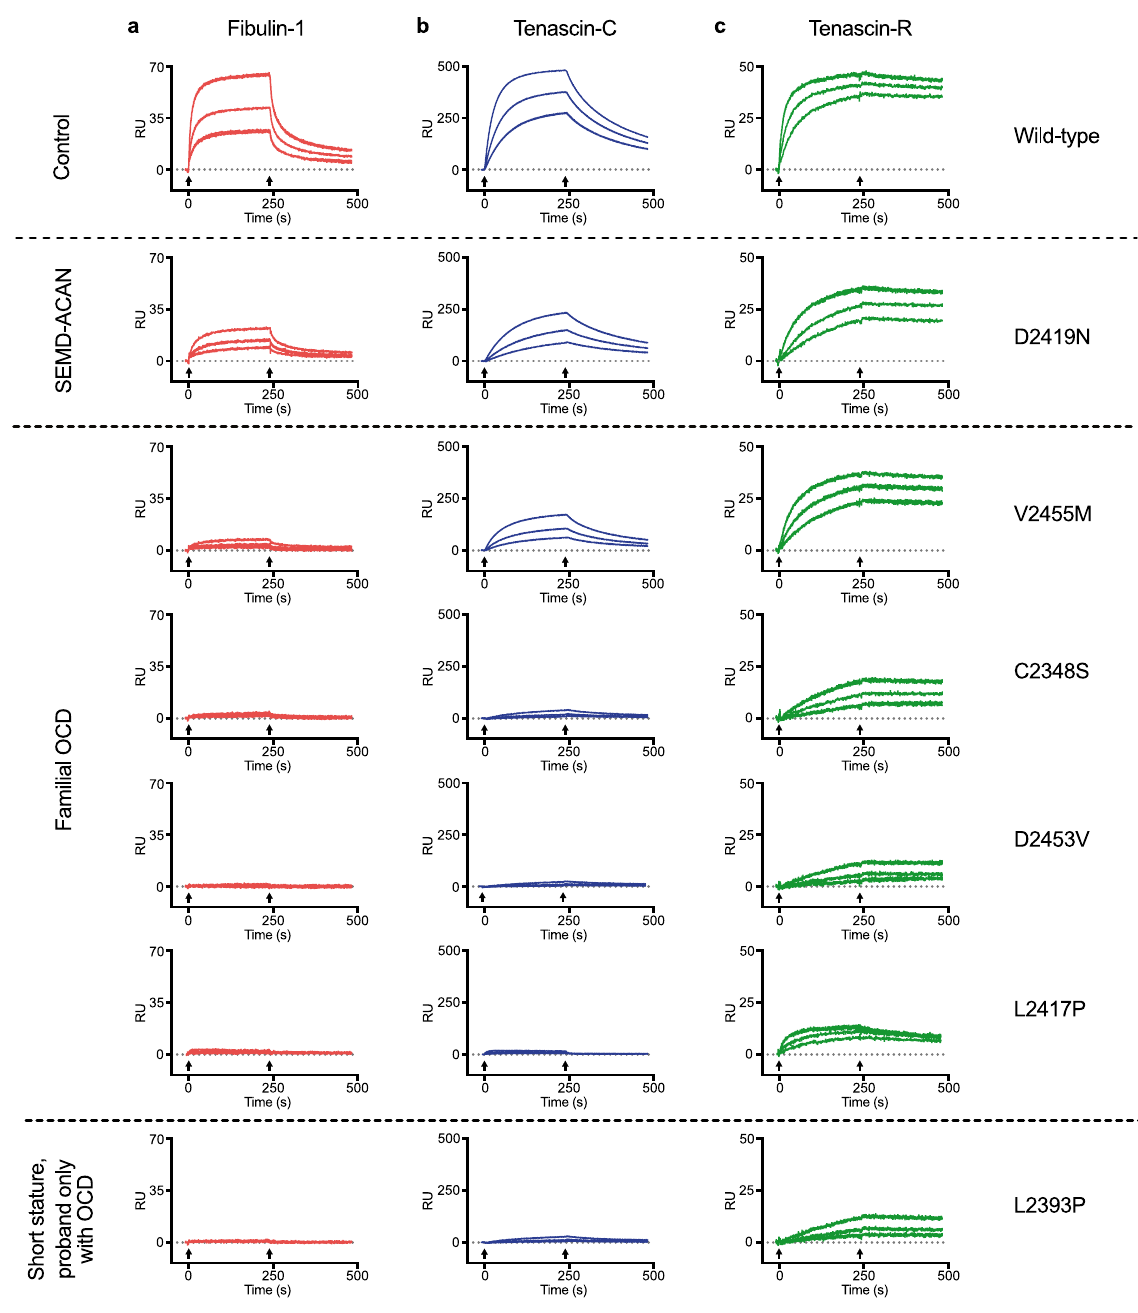
Figure 7. Impaired interactions of fOCD variant aggrecan G3 domains. Biacore surface plasmon resonance sensorgrams showing binding and dissociation of recombinant aggrecan G3 domains to immobilized cartilage ligands fibulin-1 ( a ) and tenascin-C ( b ) and the central nervous system ligand tenascin-R ( c ). Recombinant aggrecan G3 variants (E1E2LCt splice-form) injected at 50, 100 or 200 nM over the immobilised ligand surfaces. Duplicate injections of each concentration are shown in the graphs, with the start and end of injections marked by arrows under each curve. Note pronounced loss of binding of fOCD variants to fibulin-1 and tenascin-C ( a , b ). The SEMD-ACAN variant p.D2419N shows less affected binding, whereas as an ACAN variant linked to idiopathic short stature with OCD in the proband (p.L2393P) shows binding similar to the fOCD variants. Interaction with the central nervous system ligand tenascin-R ( c ) is less affected than the cartilage ligands, with residual binding of all aggrecan